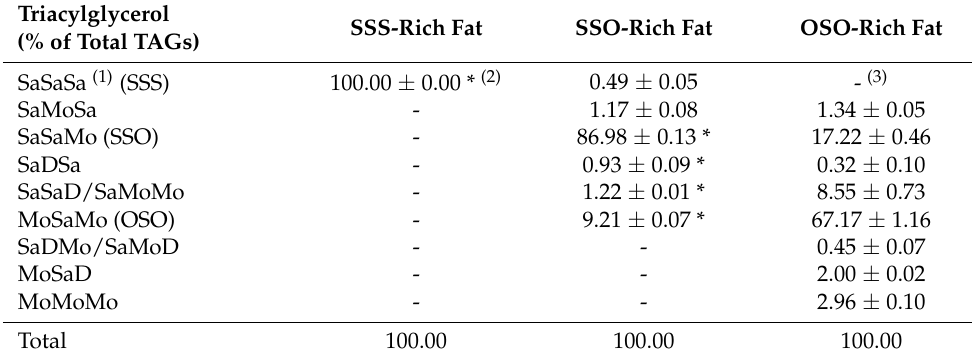
Table 4. The triacylglycerol composition of SSS-rich, SSO-rich, and OSO-rich